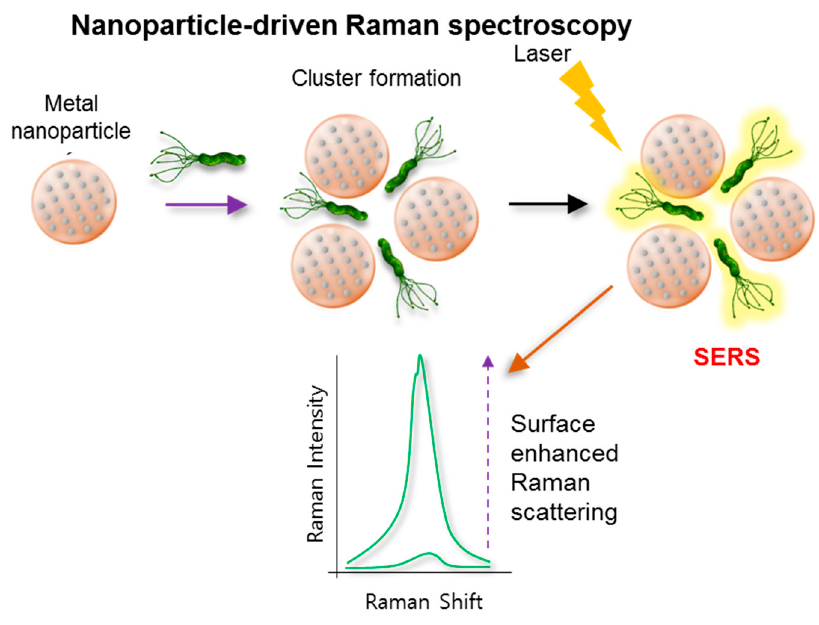
Figure 6. Schematic of the nanoparticle-driven Raman spectroscopic tools for the detection of the pathogen. The optical properties of nanoparticles vary when particles and target cells are agglomerated. Surface-enhanced Raman scattering (SERS) generates plasmonic nanostructures and enhances the Raman scattering of adsorbed molecules (e.g., gold nanoparticles) upon the irradiation of a specific laser wavelength, resulting in the enhanced Raman scattering of adsorbed molecules (e.g., Raman reporters). SERS efficiency is directly related to the proximal distance among the cluster’s plasmonic particles.